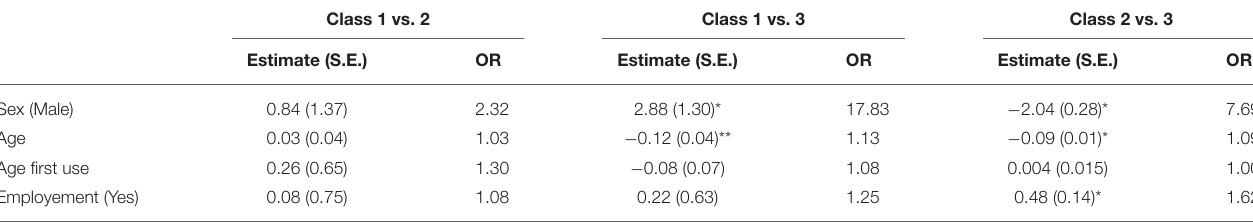
TABLE 4 | Odds coefficients for the 3-class model with sex, age, age first use, and employment as